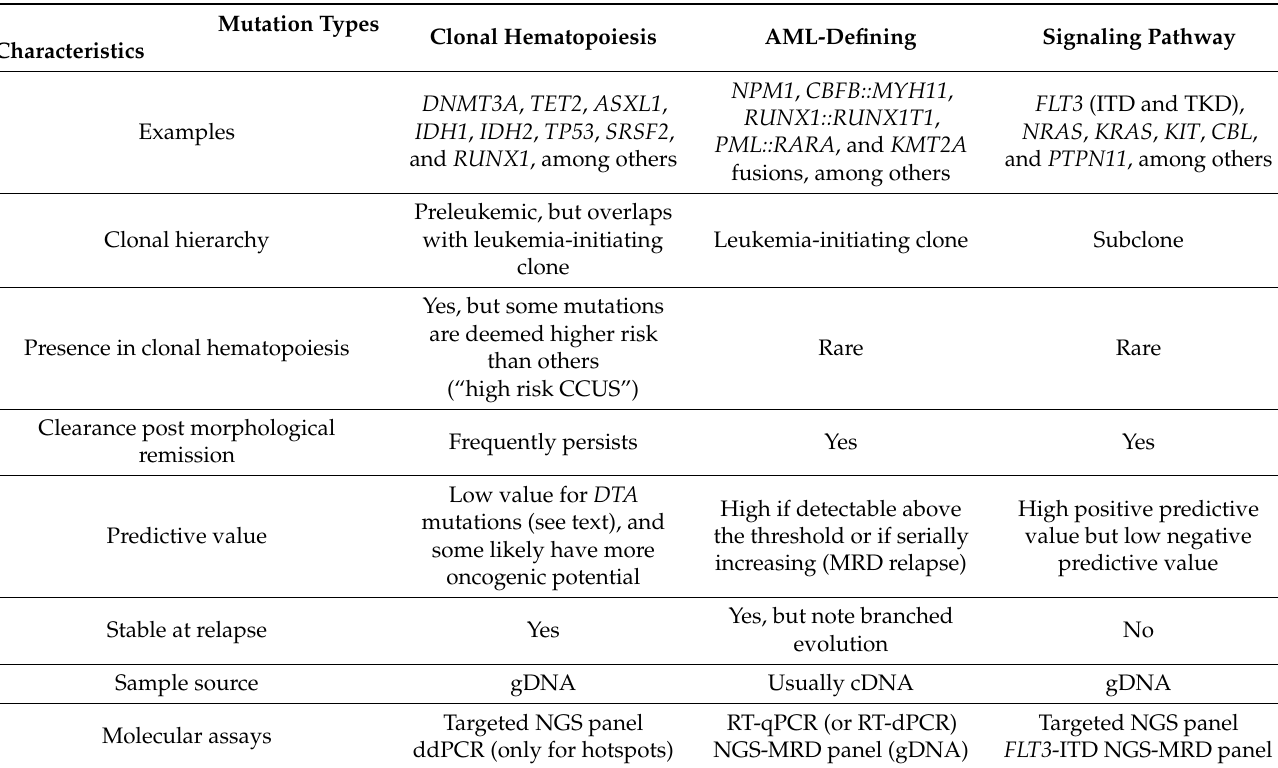
Table 1. Established and emerging molecular markers according to mutation